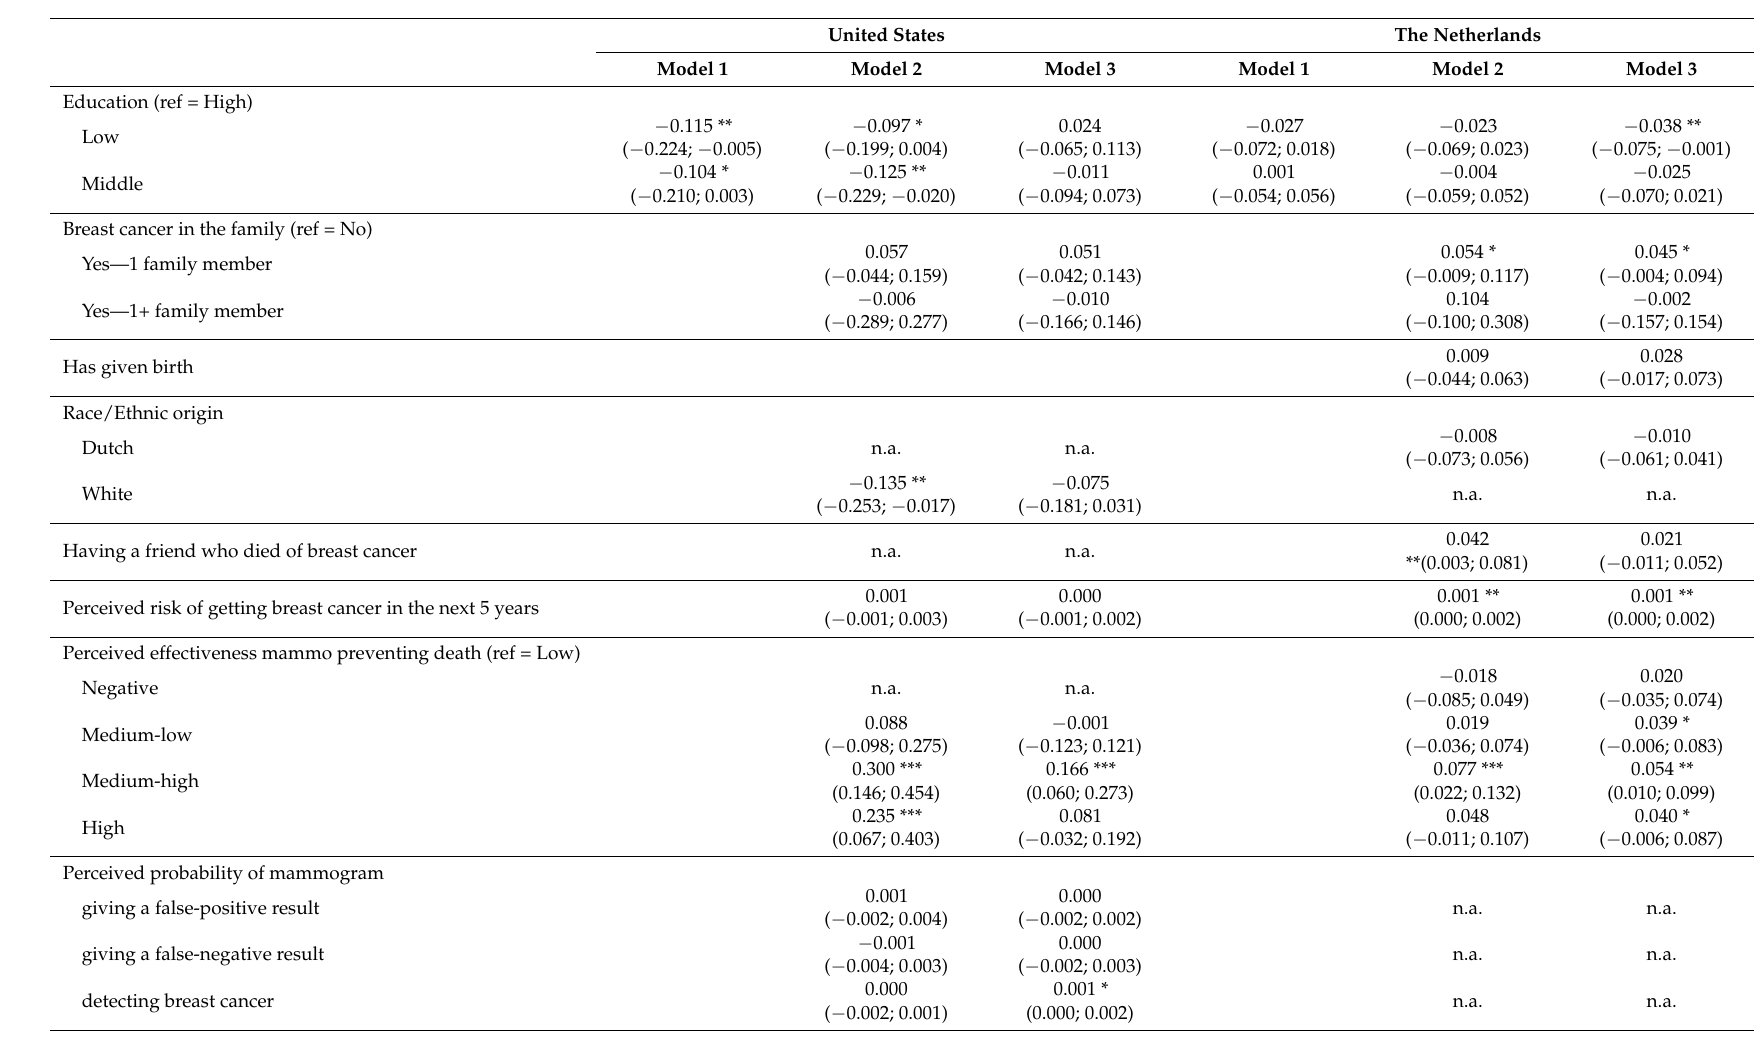
Table 3. Age-adjusted differences in probability of screening mammogram by